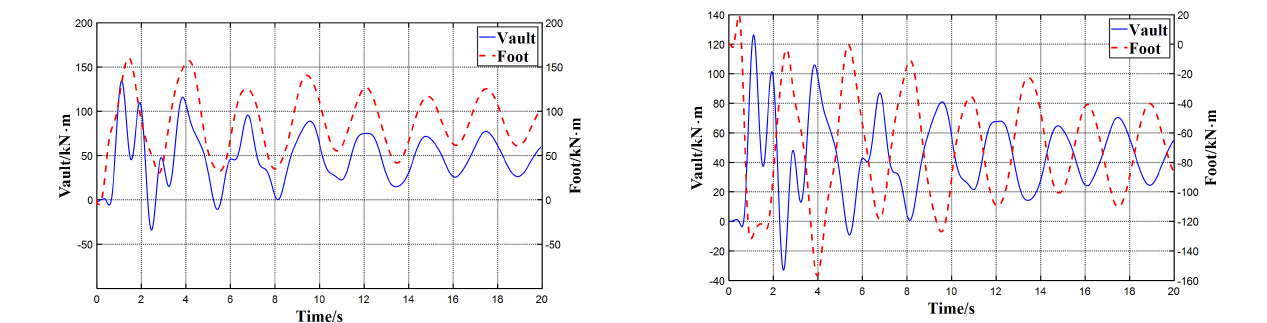
Fig. 12. Bending moment under longitudinal seismic input